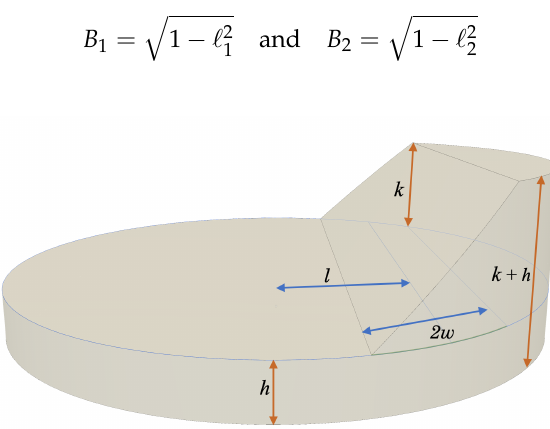
Figure 2. Graphical representation of a continuous edge signal (modeled as a linear ramp using Equation (34)) within the unit circle, including background intensity h , peak intensity of edge k , edge width w , and distance from the origin to the midpoint of the edge (cid:96)